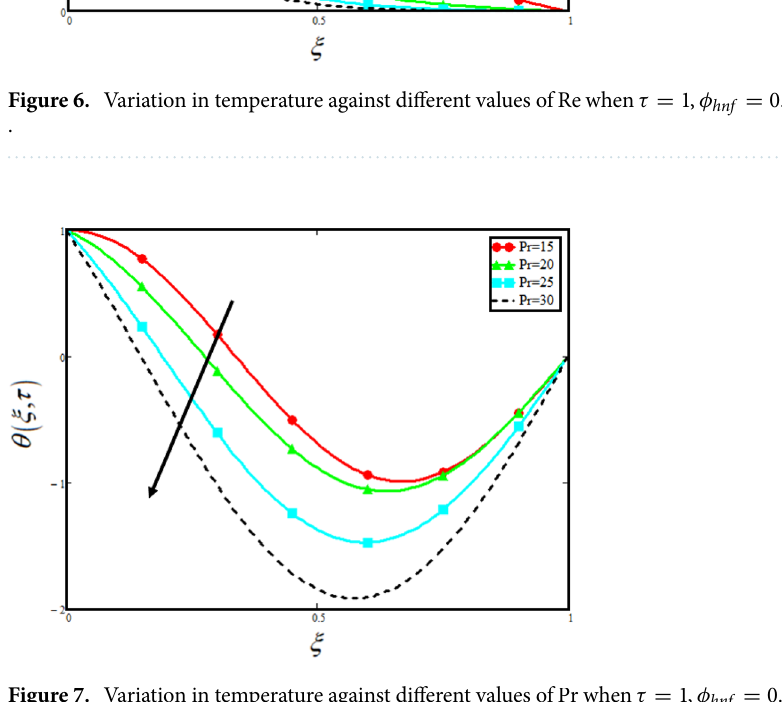
Figure 7. Variation in temperature against different values of Pr when τ = 1 , φ hnf = 0.02 , α = 0.5 and Re = 1.2